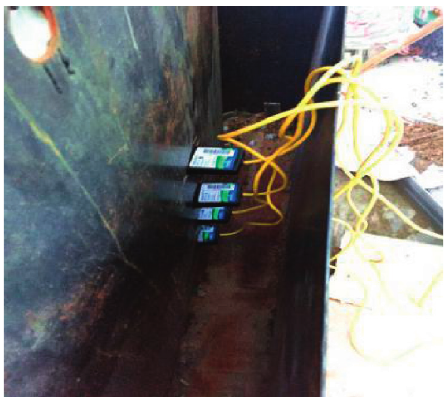
Figure 8: Moisture tester